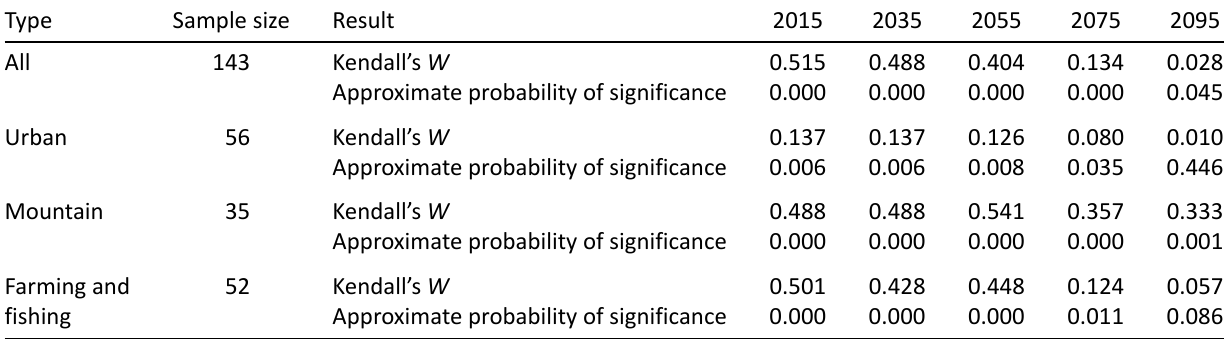
Table 8. Analysis results of Kendall’s concordance coefficient between the level of heat wave adaptation policy and the heat wave effect by municipality type.